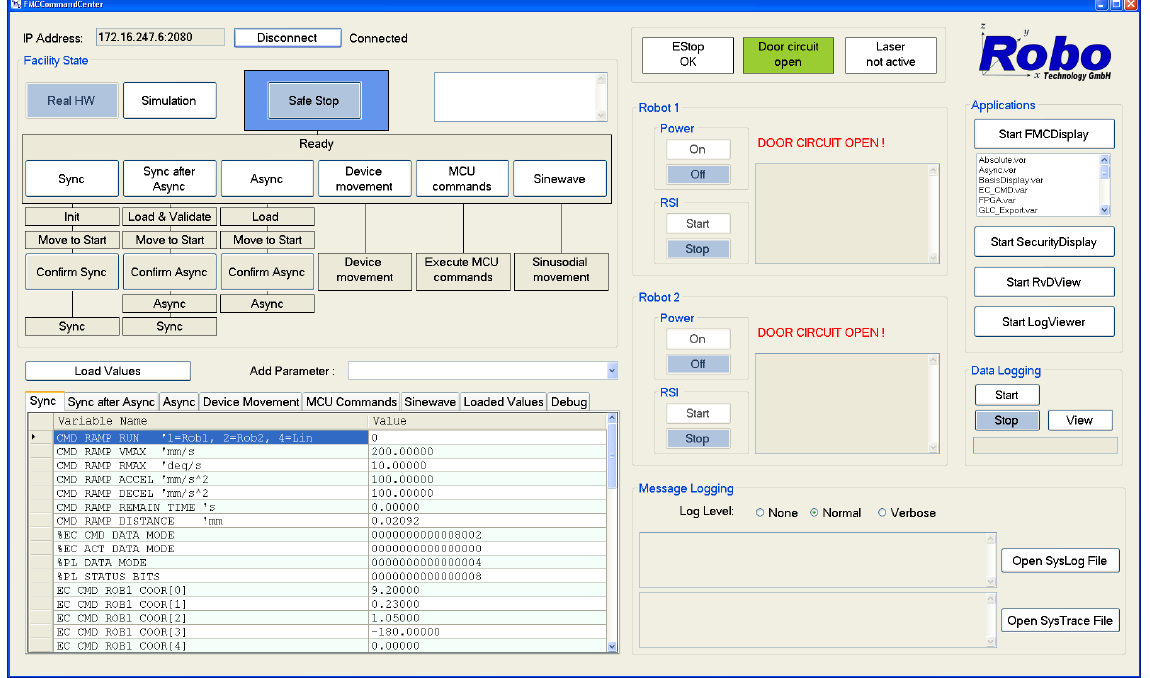
Figure 10: FMC Command Center - User interface software for monitoring and control of the simulata-